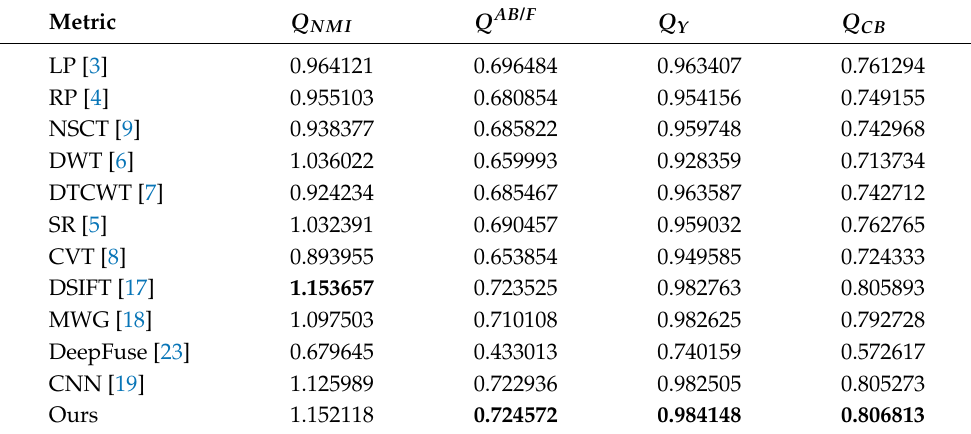
Table 1. Average scores of various methods on the four